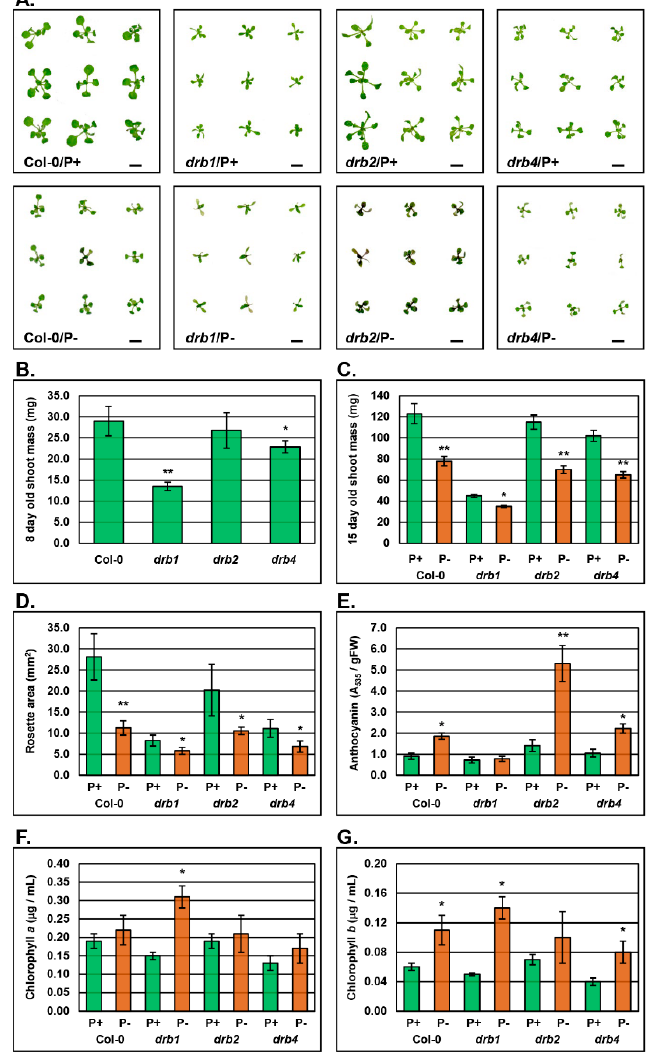
Figure 1. The aerial tissue phenotypes displayed by 15-day old Arabidopsis plant lines Col-0, drb1 , drb2 and drb4 post exposure to a 7-day period of PO 4 starvation. ( A ) The aerial tissue phenotypes expressed by non-stressed (top row of panels) and PO 4 -stressed (bottom row of panels) 15-day old Col-0, drb1 , drb2 and drb4 plants. Scale bar = 1cm. ( B ) Quantification of the shoot mass of 8-day old Col-0, drb1 , drb2 and drb4 seedlings germinated and cultivated under standard growth conditions. ( C ) The shoot mass of non-stressed and PO 4 -stressed 15-day old Col-0, drb1 , drb2 and drb4 plants. ( D ) The rosette area